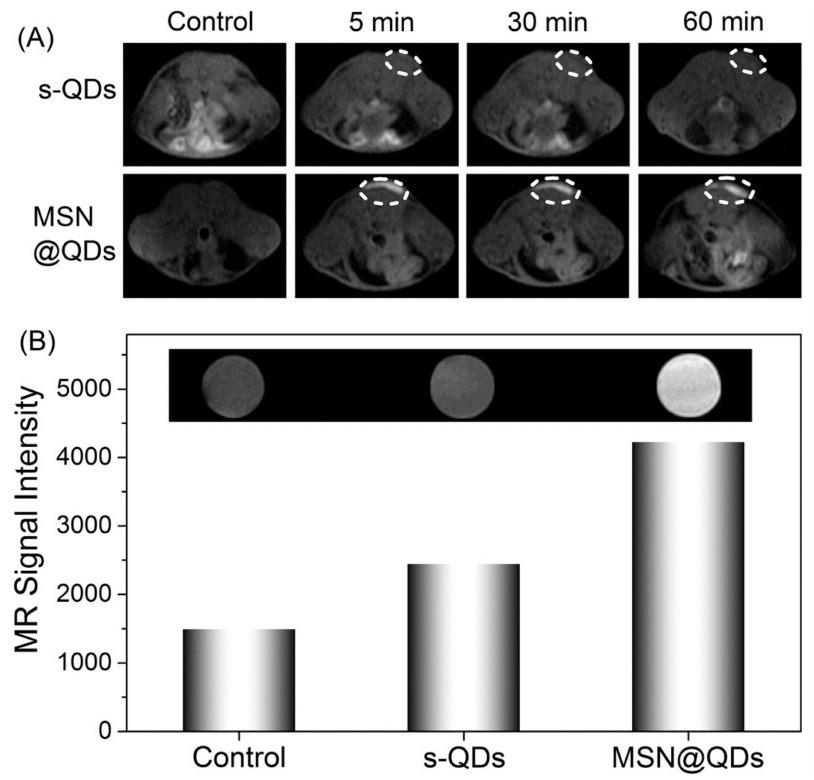
Figure 16. Comparison of pre- and post-injection MR images of a Balb/c mouse injected with s-QDs and MSN@QDs: MR coronal pictures at T1 weighting ( A ) and the associated MR signal intensity ( B ) as measured in vitro